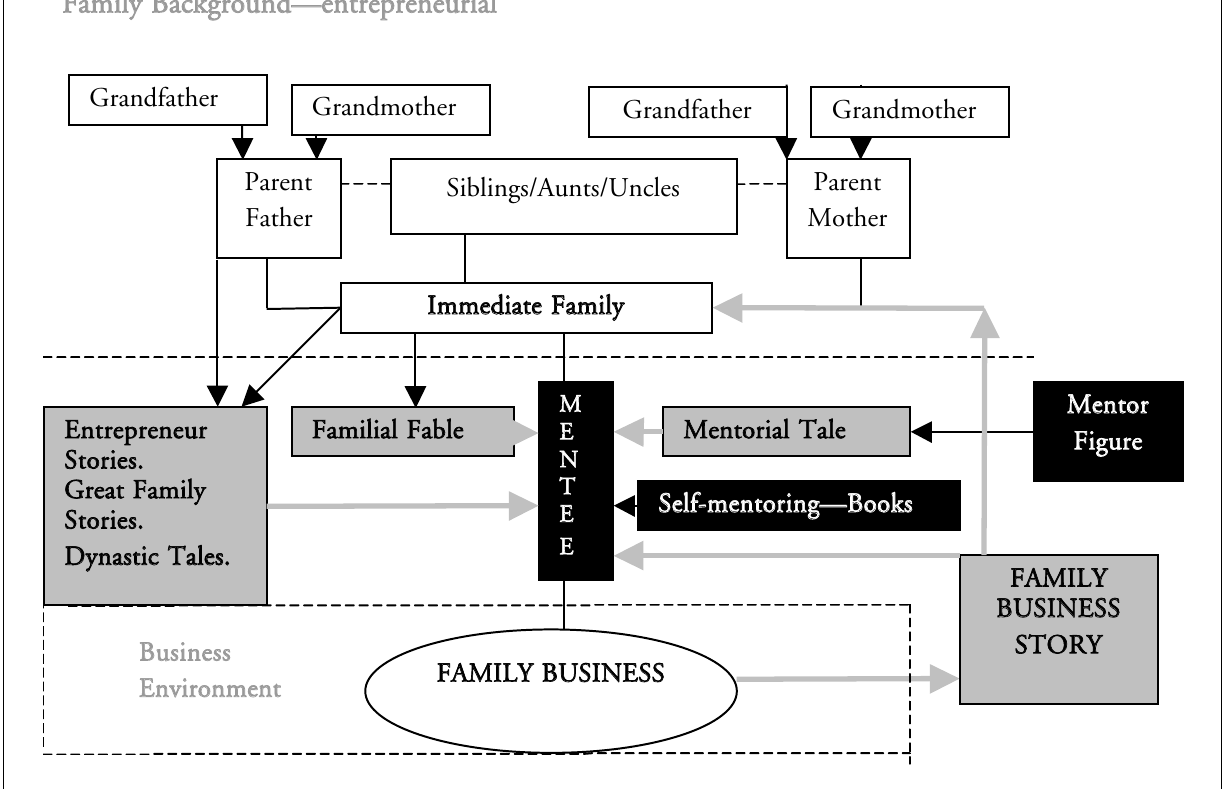
Figure 1. The Contingent Nature of Narratives of Family